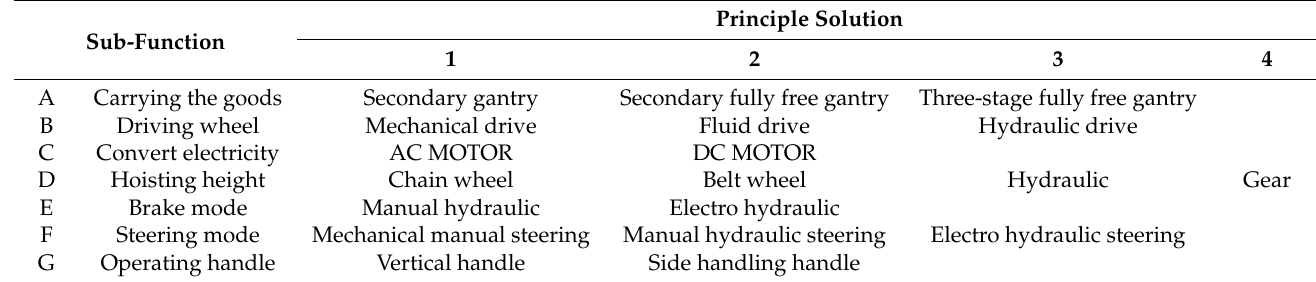
Table 5. Morphology matrix of electric forklifts.